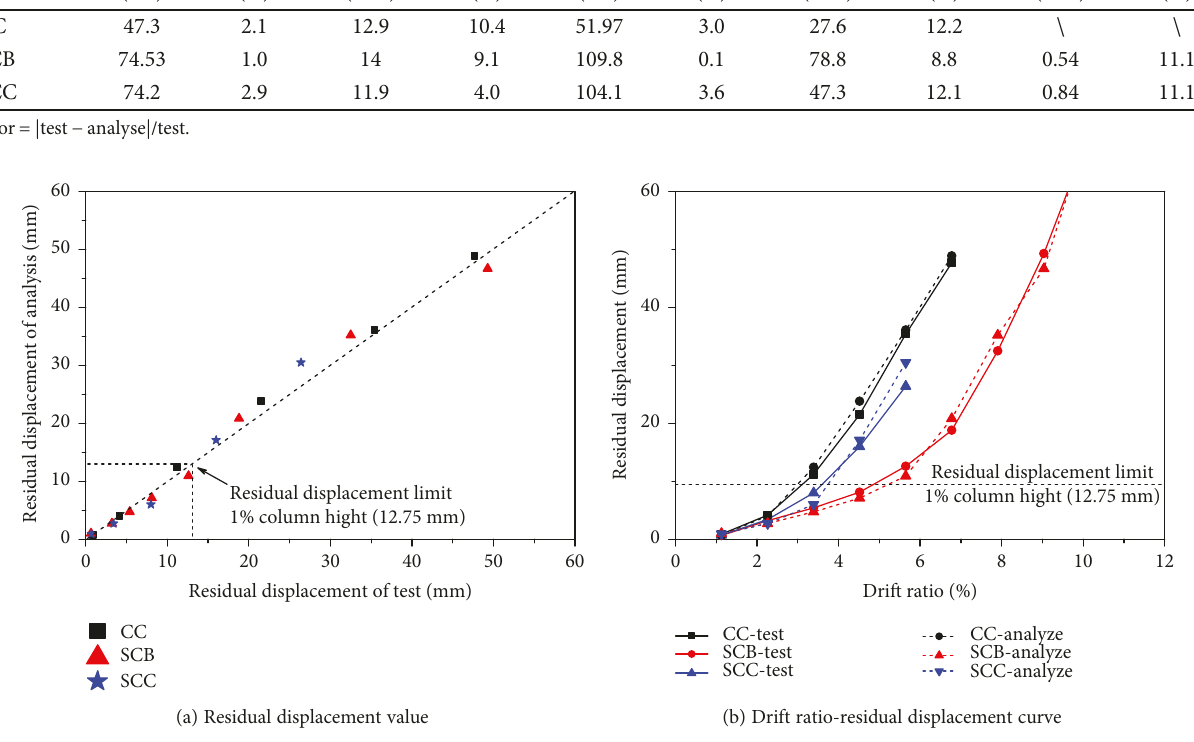
Table 4: The characteristic values of calculated L-D hysteresis curves and the error to the test results. Specimen